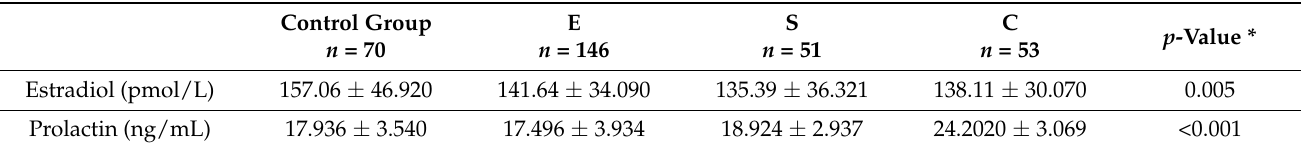
Table 2. Comparison between different autoimmune thyroid disease (AITD) groups and healthy patients in terms of hormonal parameters.